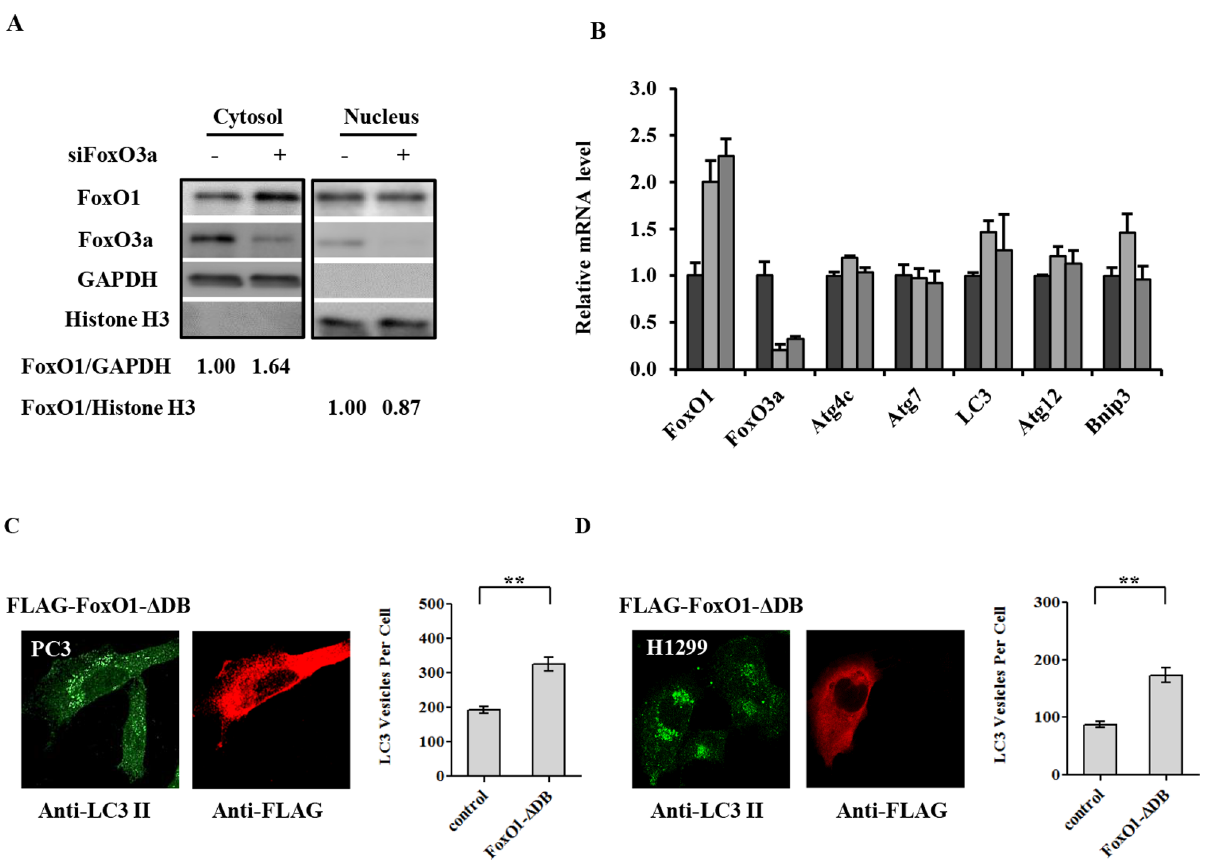
Fig. 5. Increased cytosolic FoxO1 resulting from FoxO3a knockdown leads to the elevated level of autophagy. (A) PC3 cells were transfected with siRNA for luciferase (-) or FoxO3a (siFoxO3a) as indicated, and harvested for immunoblot analysis of the indicated proteins 72 h after transfection; see Experimental Procedures for details. Histone H3 and GAPDH were used as loading control for nuclear and cytosolic proteins, respectively. The band quantity ratios, FoxO1/GAPDH and FoxO1/Histone H3, for each condition were obtained using ImageJ. (B) Real-time PCR analysis for the relative expression levels of the indicated autophagy-related genes 48 h after transfection of PC3 cells with control siRNA (black) or two different siRNAs targeting FoxO3a (light and dark grey, respectively). Data was presented as Mean ¡ S.D. (C, D) Over-expression of a transcription function inactive/cytosolic form of FoxO1, FoxO1- D DB, increases autophagy. The quantities of LC3 positive vesicle of both PC3 (panel C) and H1299 (panel D) cells were compared in the same analysis between Flag-FoxO1- D DB over-expressing cells and un-transfected cells. FITC and rhodamine tagged secondary antibodies were used for the detection of anti-LC3 or anti-Flag tag, respectively. The autophagy level in each cell population was quantified using MetaMorph software; the data were plotted on the right side of each panel. . 50 cells were analyzed for each condition. Data was presented as Mean ¡ S.E.M. (‘‘**’’, p ,